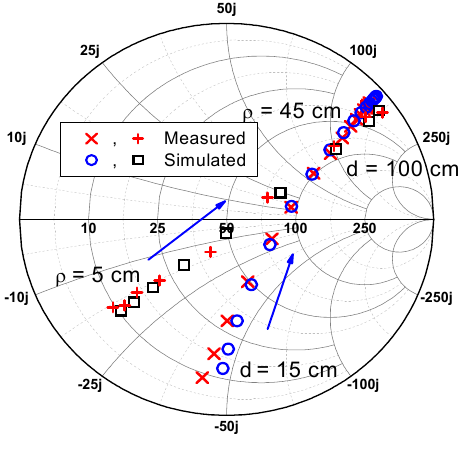
Figure 7. Measured and simulated Z IN for distance and alignment changes.